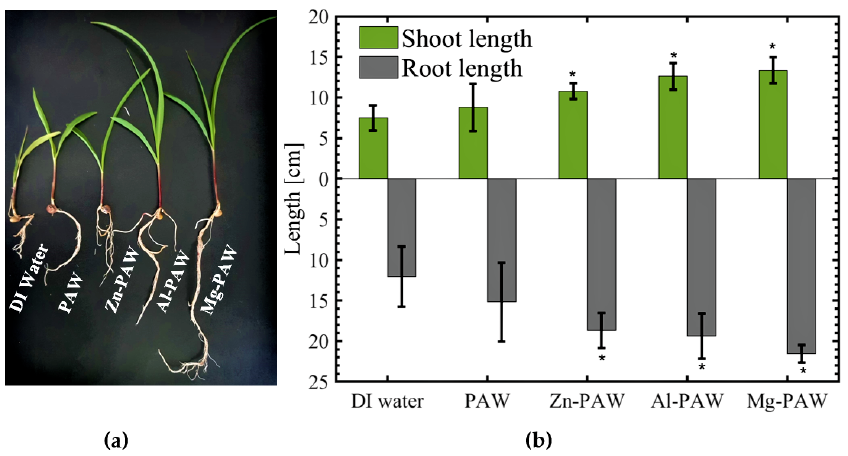
Figure 5. ( a ) Photograph of corn plants and ( b ) average shoot (including leaf) and root lengths on the 10th day after sowing on vermiculite, and after soaking in DI water, only PAW, PAW with Zn (Zn-PAW), PAW with Al (Al-PAW), or PAW with Mg (Mg-PAW). The symbol ∗ is for t-test result which rejects the null hypothesis at the 5% significance level.